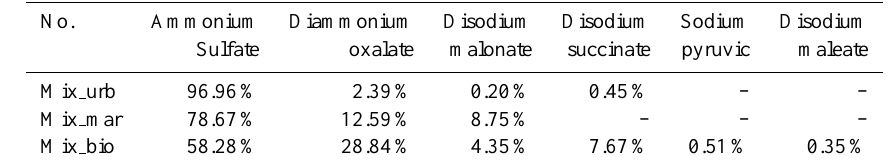
Table 4. The chemical composition of mixtures, mass percentage, wt%. No.